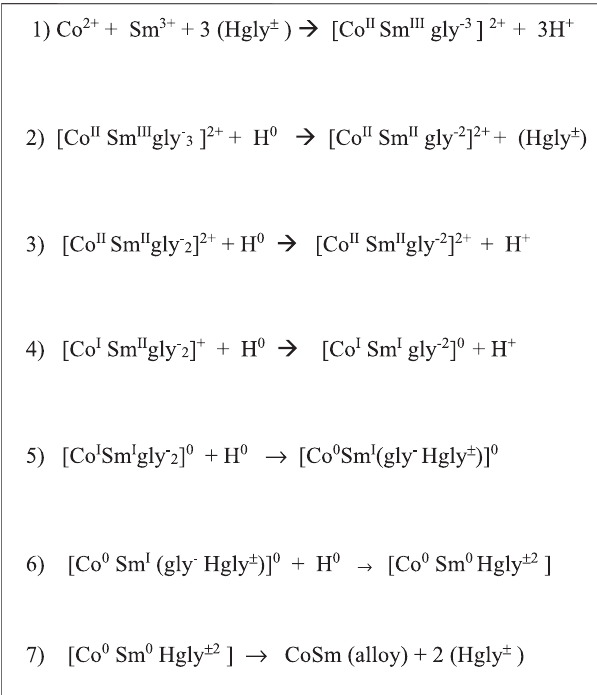
FIGURE14| ProposedstepwisereductionofSm-Coglycinecomplexes by H